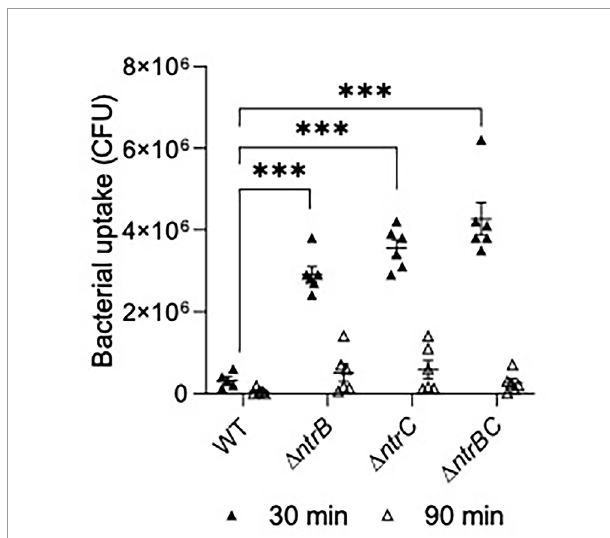
FIGURE 7 | Mutation of the nitrogen regulatory two-component system, NtrBC, increased uptake of P. aeruginosa by macrophages. Con fl uent THP-1 monocytes (~3.0 x 10 5 cells/well) were differentiated and treated with mid-log phase bacteria at a multiplicity of infection (MOI) = 10 and incubated at 37°C for 30 min. Cells were washed, treated with gentamicin (500 µg/ml) for 30 min, and washed again to remove any residual bacteria in the supernatant. Cell lysates at t = 0, 60 min were plated for bacterial enumeration following serial dilution. Mutants were taken up and cleared from macrophages more ef fi ciently than the WT. Data are presented as geometric mean ± standard deviation for three independent experiments containing 2 biological replicates each ( n = 6). ns, not statistically different; *** P < 0.001 different according to Two-way ANOVA followed by Dunnett ’ s post-hoc